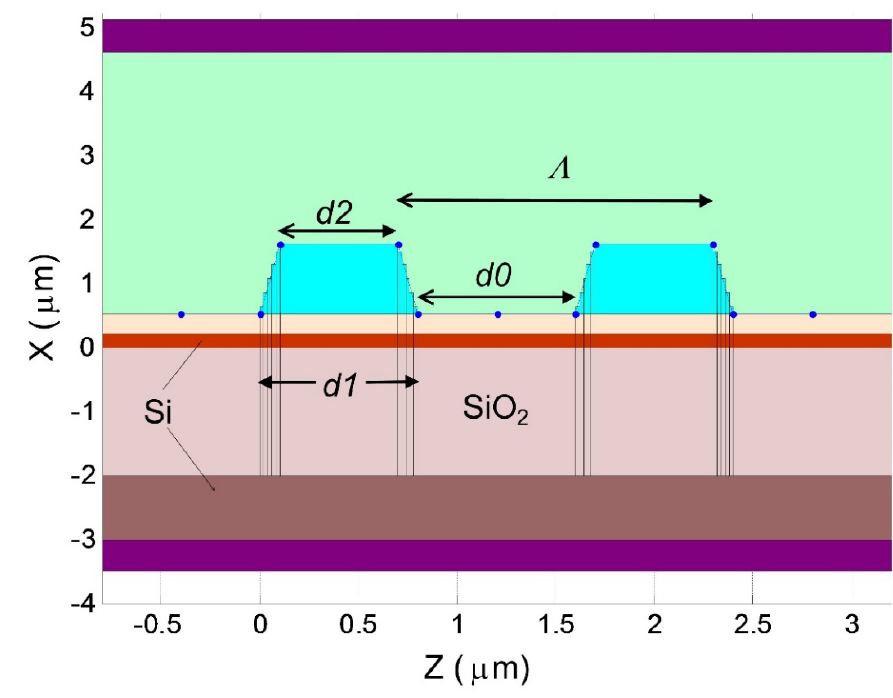
Figure 2. A general view of the waveguide structure with inclined boundaries for transmission of light in a photonic silicon wire (Si) containing a segmented structure of a large number of periodically arranged dielectric inserts. The inclined boundaries are determined by the parameters: d 1, d 2, dD = d 1 − d 2 and d 0. The top and bottom rectangular layers represent the PML layered to suppress the back reflection from the boundary of the simulation region.